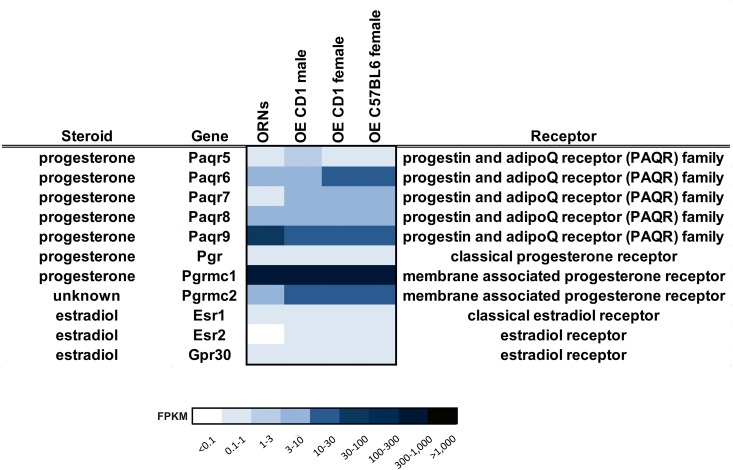
Expression level of steroid receptors detected by RNA-Seq.Heat Map showing the transcript expression level of steroid receptors in ORNs and OE [36]. Deeper colors indicate a higher expression level.